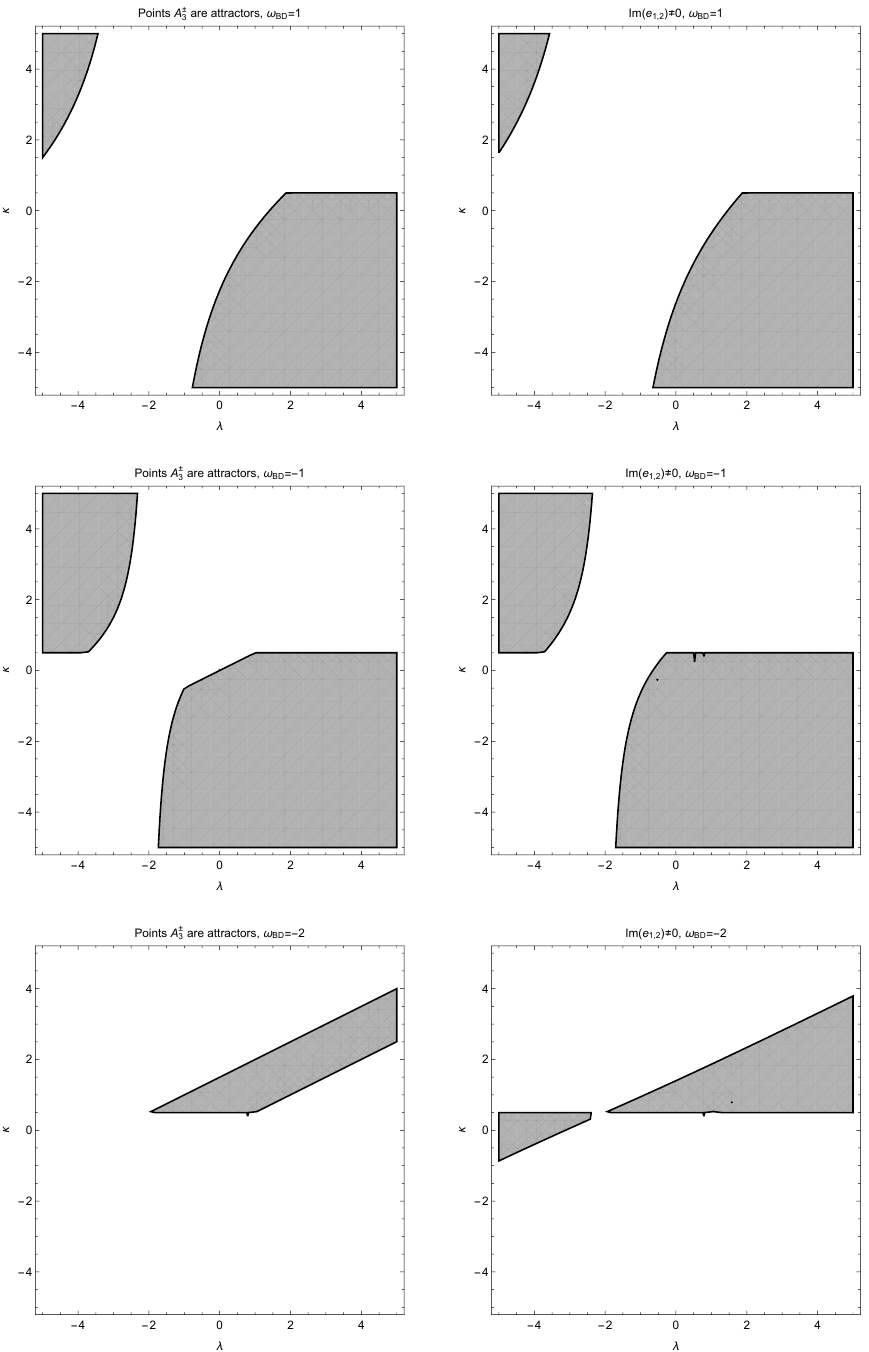
(cid:0) (cid:1) A ± in the plane ( λ , κ ) 3